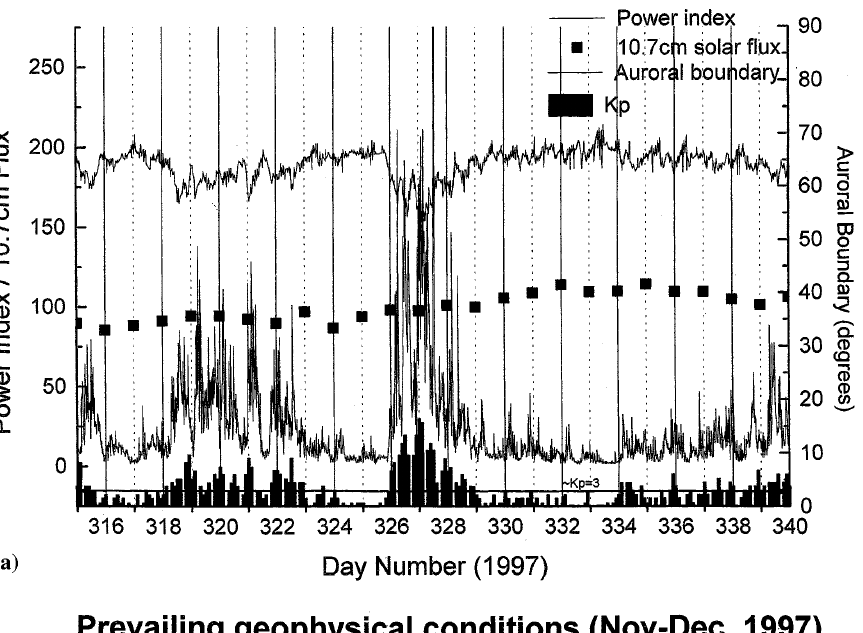
Fig. 1a, b. The prevailing geophysical condition for the period from a November 12 to December 5, 1997, and b December 6 to December 31, 1997. In each case the top trace shows the location of the equatorward edge of the auroral oval from the DMSP spacecraft. The solid squares show the 10.7 cm solar flux and the lower histogram shows the K index. The middle trace shows the p time history of the auroral power as measured by the TIROS/NOAA polar